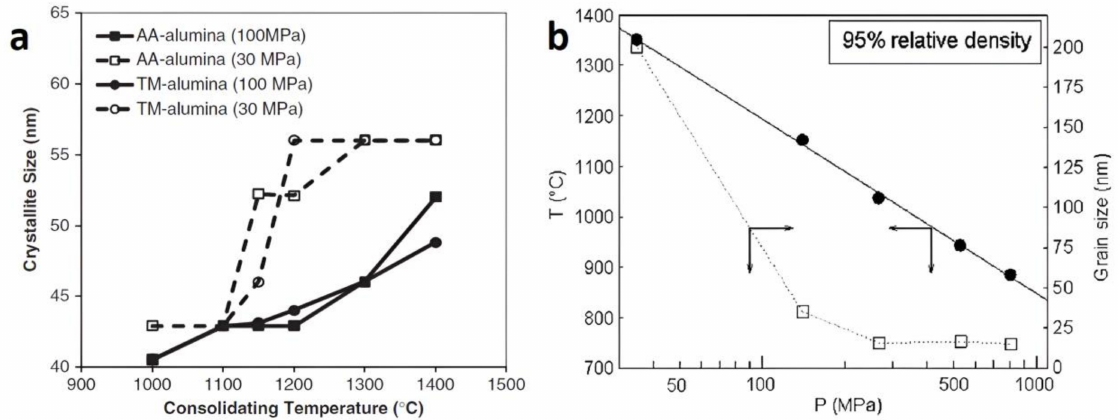
Figure 1. ( a ) Dependence of crystallite size on SPS with temperature and applied pressure for two different commercial powders of alumina (TM-alumina and AA-alumina) (from [26]). ( b ) Relationship between the pressure required and the dwell temperature (5 min) to obtain samples with a relative density of 95% in the case of nanometric zirconia (8% YO 1.5 ). The full circles correspond to the temperature of sintering and empty squares to the grain size obtained (from